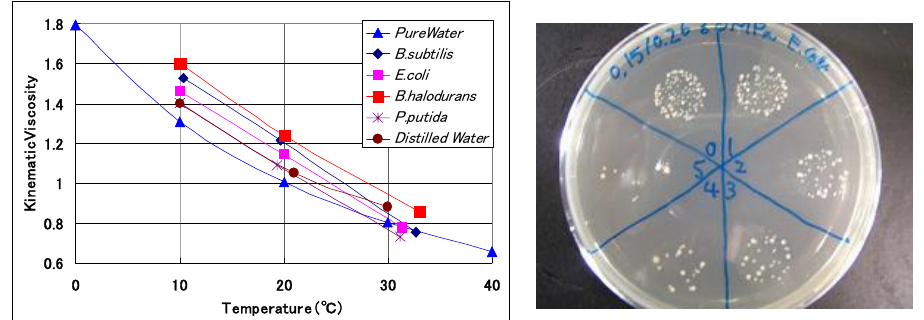
Fig. 5. Kinematic viscosity of water with bacteria Fig. 6. Colonies of E. coli on solid